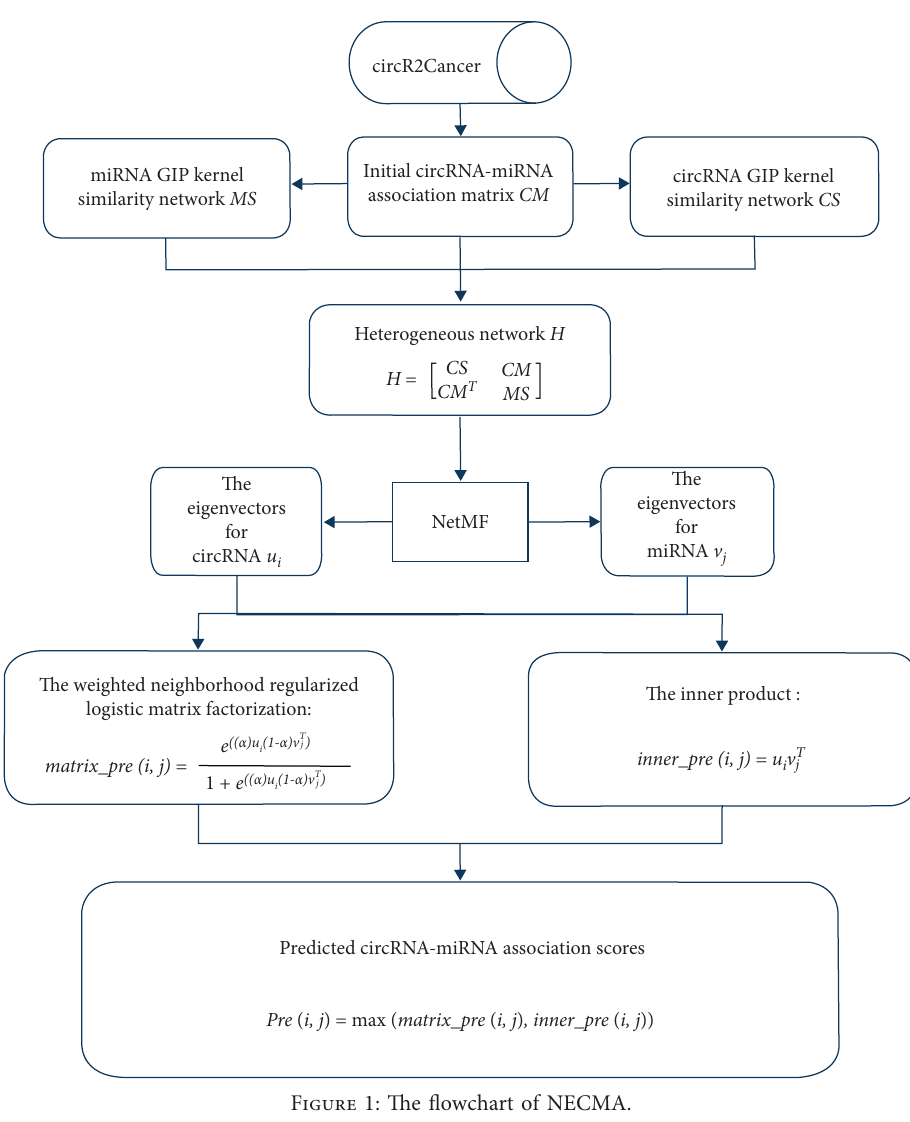
Figure 1: The flowchart of